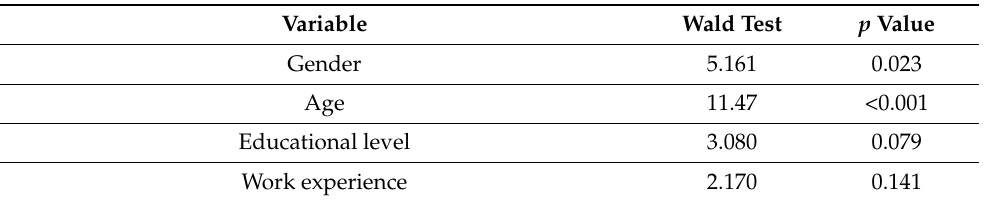
Table 6. Bivariate logistic regression analysis for the strategies used to limit suspected abusers’ access to pregabalin